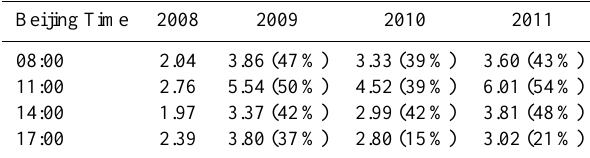
Table 4. Average tropospheric NO 2 VCDs (in units of 10 16 moleculescm − 2 ) in August from 2008 to 2011 for different times of the day. Given in parenthesis are the respective reductions of the 2008 values compared to the specified